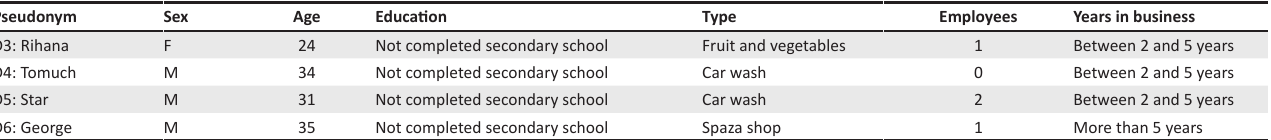
TABLE 1: Description of the participants.